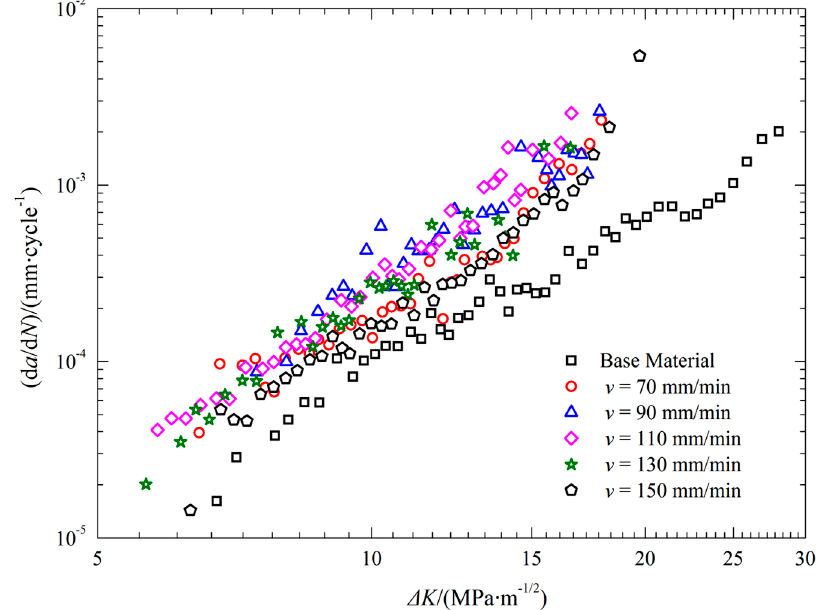
Figure 10. Fatigue crack growth rates at different advancing velocities when the rotating speed was ω = 1100 r/min.